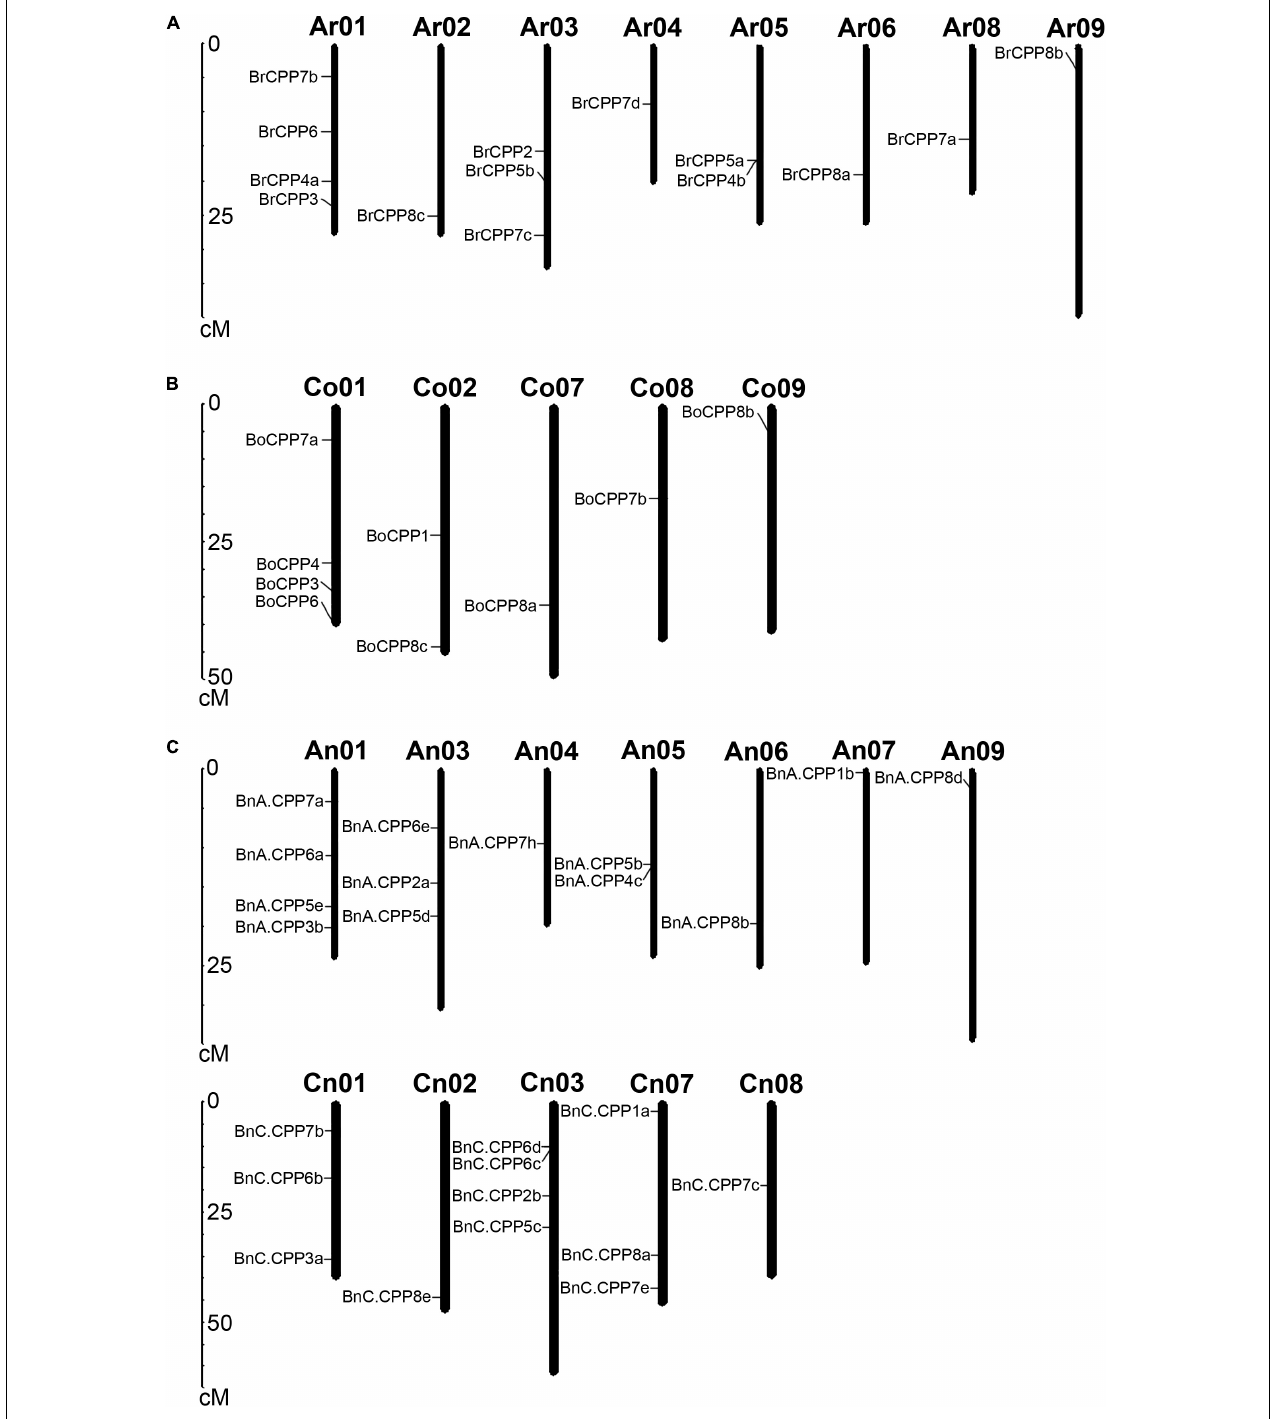
FIGURE 2 | Chromosome distribution of CPP genes in B. rapa (A) and B. oleracea (B) and B. napus (C) . All genes located in unassembled scaffolds were not shown in this figure.